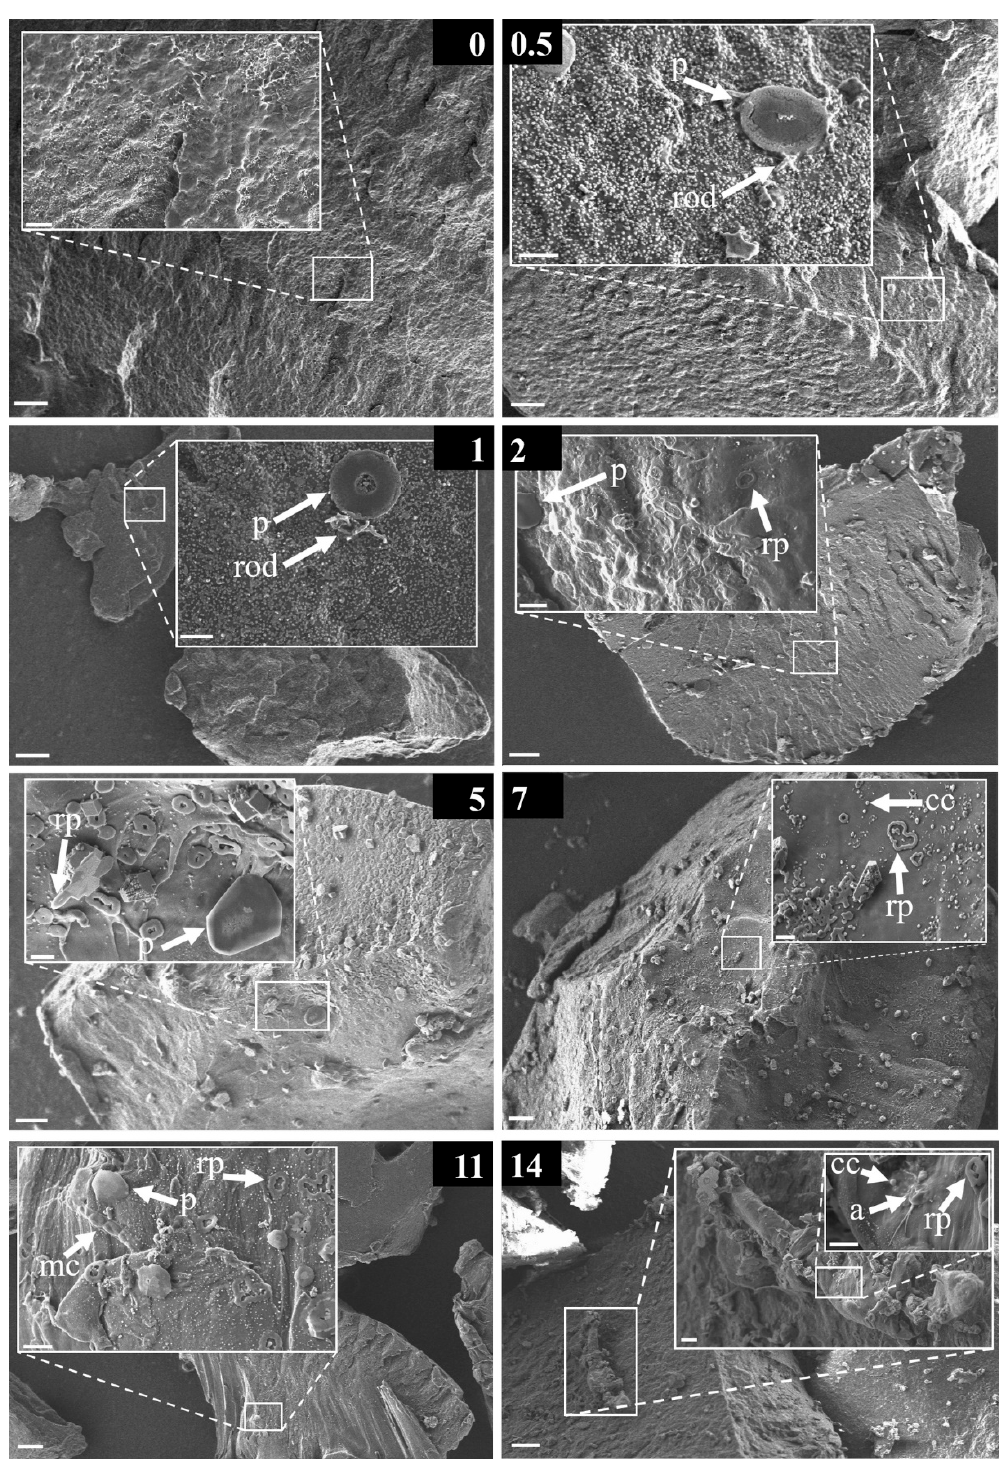
Figure 6. Scanning electron microscopy images of PET incubated in freshwater. Numbers in black boxes indicate incubation times in days (0 = raw material, 0.5 = half day, 1 = one day, 2 = two days, 5 = five days, 7 = seven days, 11 = eleven days, 14 = 14 days of incubation). Microorganismal structures are highlighted with arrows. a = non-assignable structure, rod = rod / vibrio-shaped bacteria, cc = coccoid bacteria, mc = multicellular structure, p = platelet structure, rp = round platelet structure. Scale bar: Large image 10 µm, magnified image 2 µm.